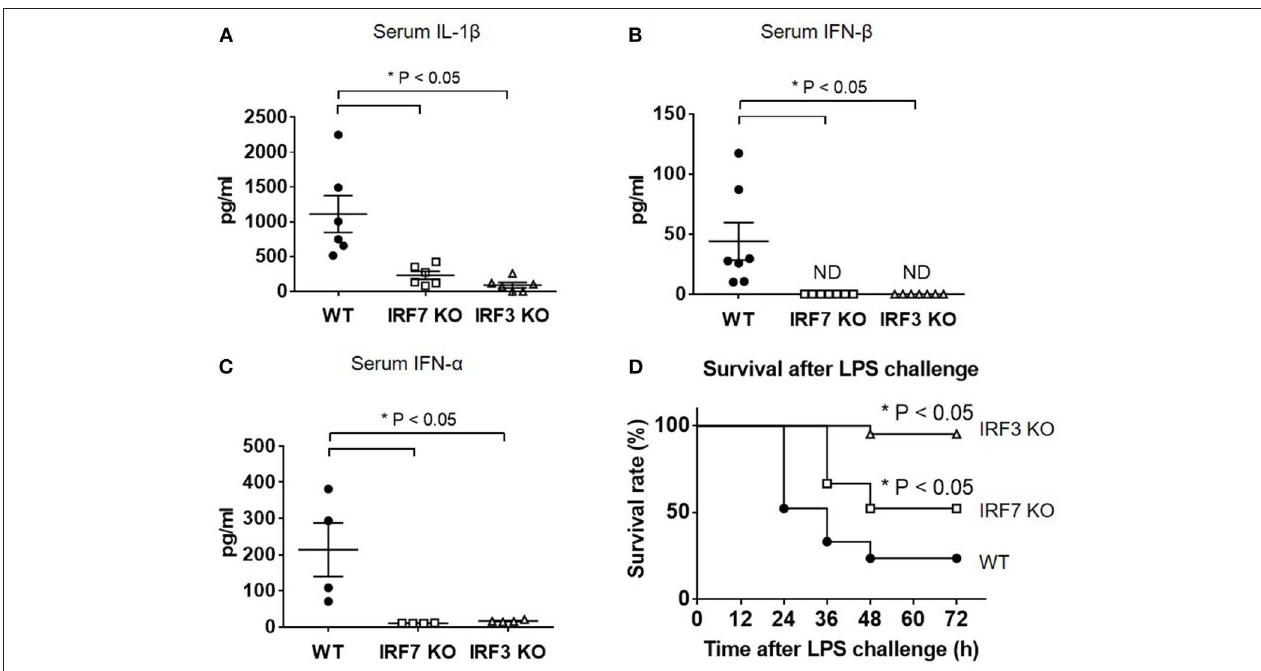
FIGURE 1 | IRF-7 facilitates IL-1 β and type I IFN responses to LPS in vivo . (A) ELISA analysis of IL-1 β cytokine levels in serum from IRF-7 or IRF-3 knockout mice ( n = 6) compared to wild-type control littermates ( n = 6), 3h after I.P. injection of 30 µ g/g LPS in sterile PBS. Data are presented as mean ± SEM. One-way ANOVA was used to calculate statistical differences (* p < 0.05). (B) ELISA analysis of IFN- β levels in serum from IRF-7 or IRF-3 knockout mice ( n = 7) compared to wild-type control littermates ( n = 7), 3h after I.P. injection of 30 µ g/g LPS in sterile PBS. Data are presented as mean ± SEM. One-way ANOVA was used to calculate statistical differences (* p < 0.05). (C) ELISA analysis of IFN- α levels in serum from IRF-7 or IRF-3 knockout mice ( n = 4) compared to wild-type control littermates ( n = 4), 3h after I.P. injection of 30 µ g/g LPS in sterile PBS. Data are presented as mean ± SEM. One-way ANOVA was used to calculate statistical differences (* p < 0.05).